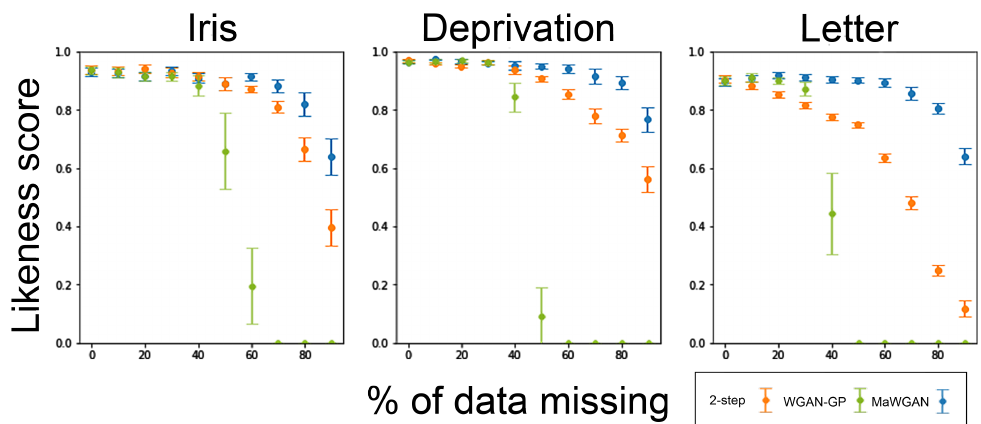
Figure 3. Likeness scores for each method on the three datasets with different levels of missingness (higher is better).